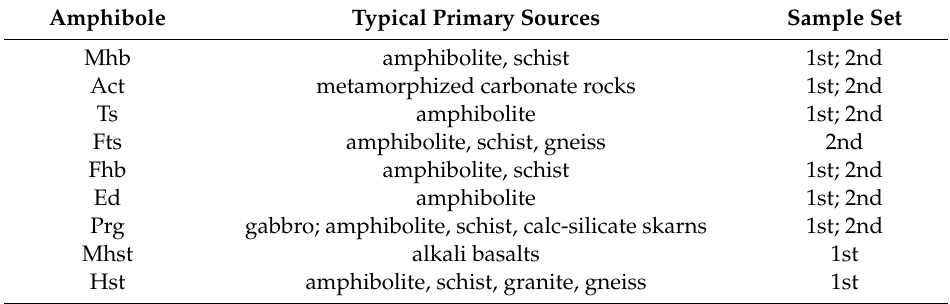
Table 5. Correspondence between the identified amphiboles, most typical primary sources and sample sets. 1st—first set of heavy mineral chemical compositional data (Northern Portuguese continental shelf). 2nd—second set of heavy mineral compositional data (Porto canyon head